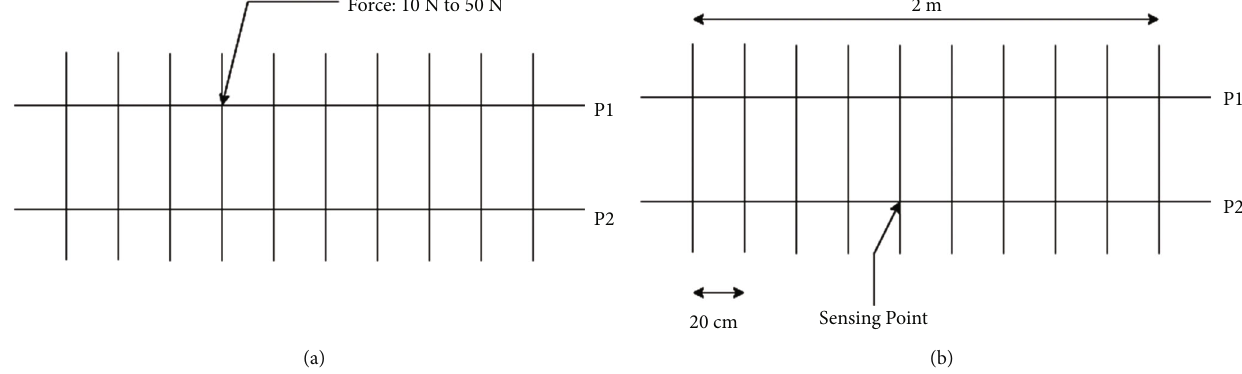
Figure 2: Characterization setup: (a) characterization of force; (b) characterization of